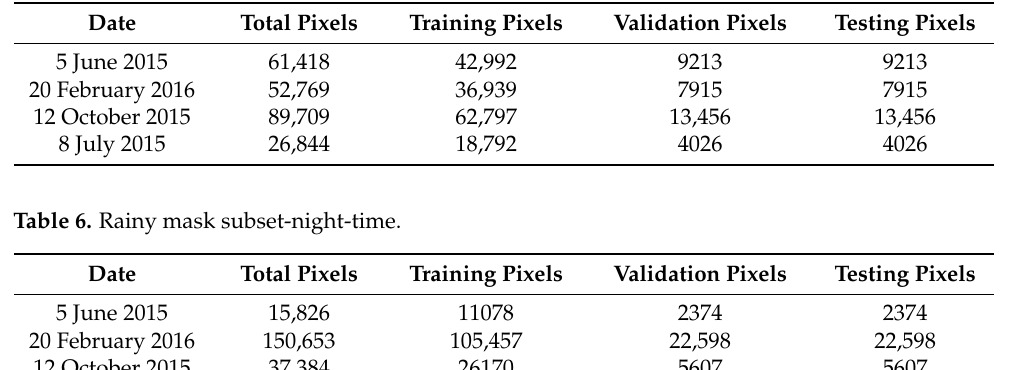
Table 5. Rainy mask subset-day-time.